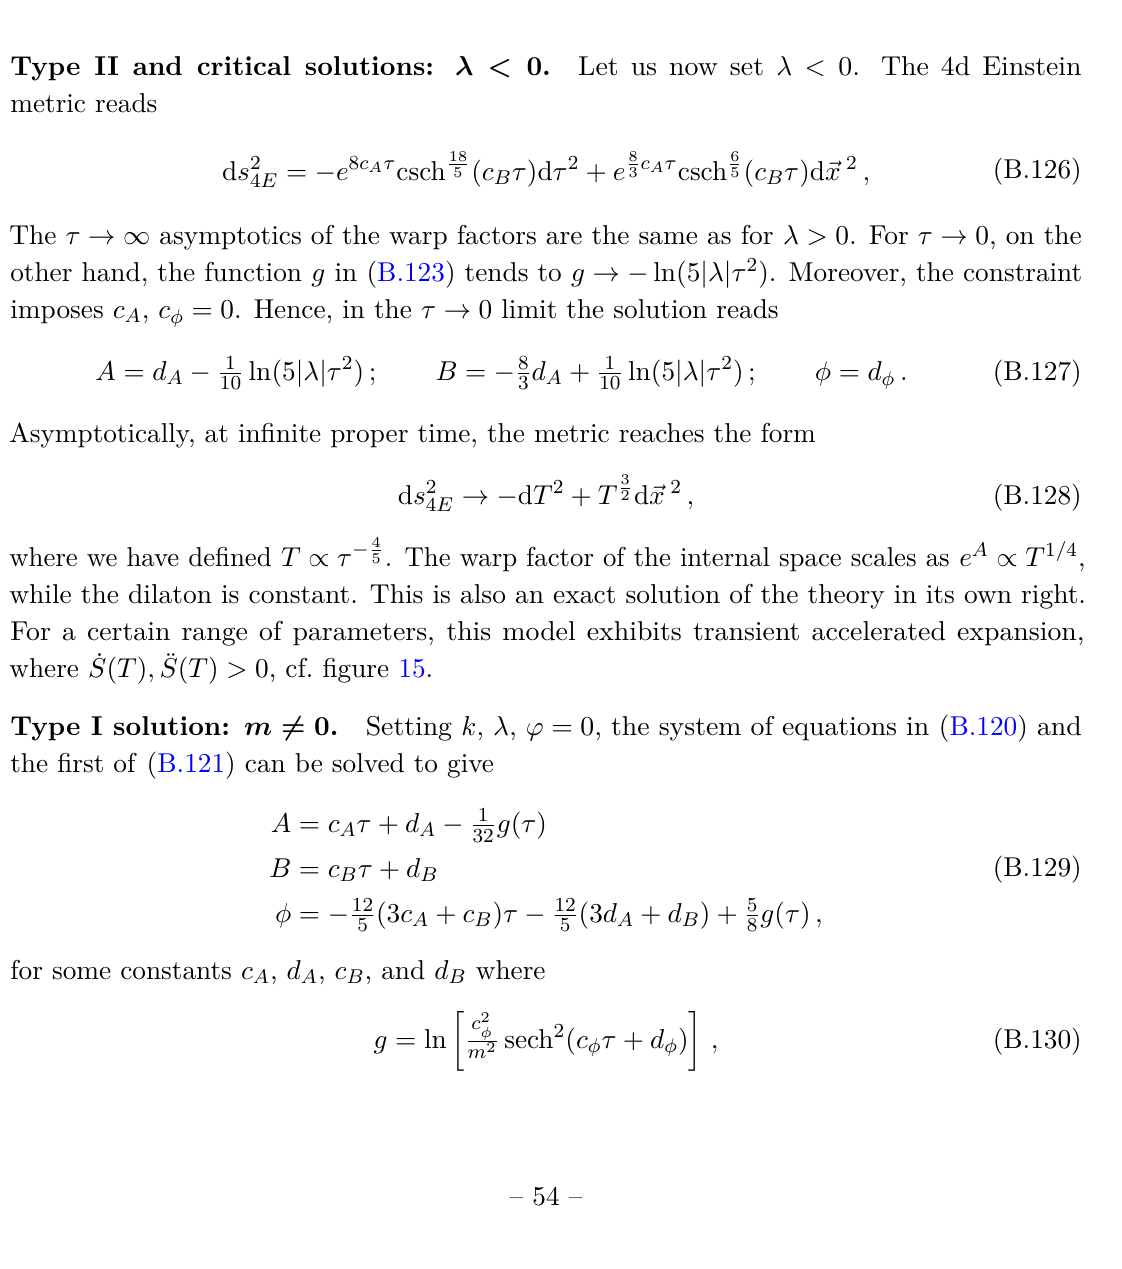
Figure 15 . Plot of have ˙ S ( T ) , ¨ S ( T ) → 0